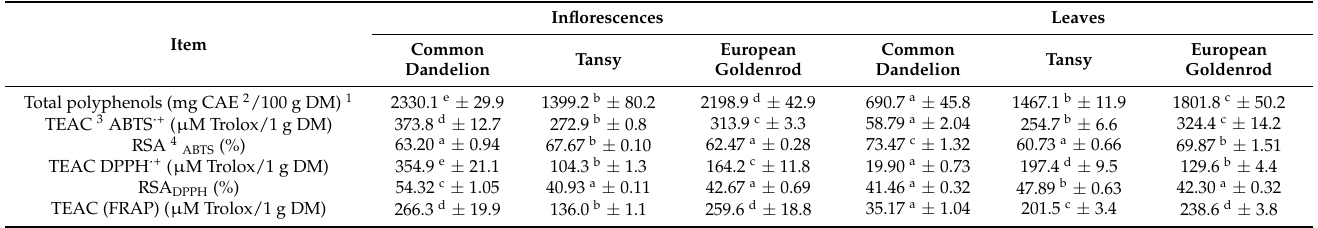
Table 4. Total polyphenols content and antioxidant activity of Asteraceae family plants (species × parts of plants